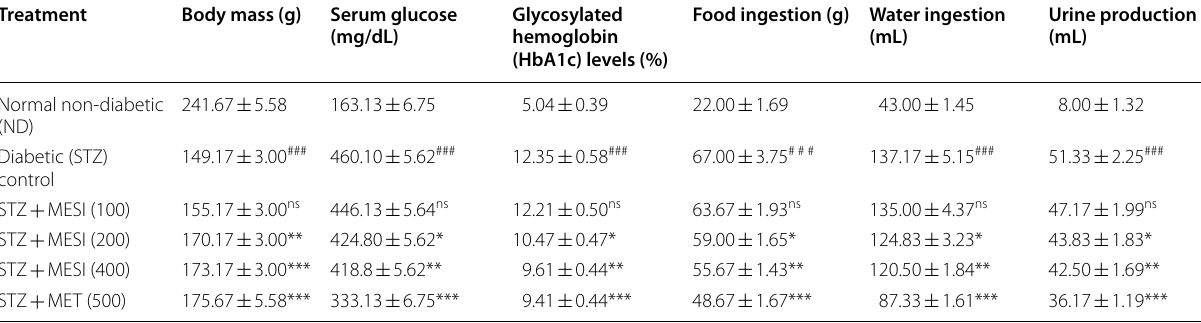
Table 1 Effect of MESI on body mass, serum glucose, glycosylated hemoglobin (HbA1c) levels, food and water ingestion, and urine production of diabetic